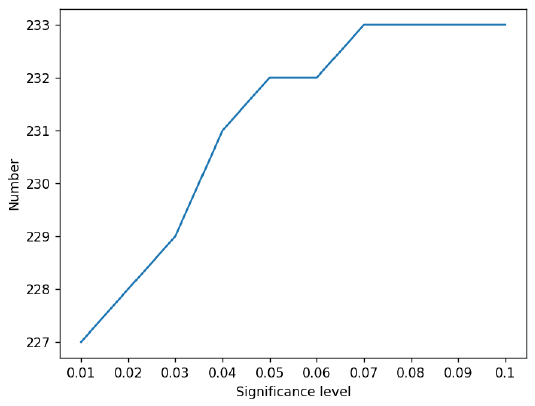
Figure 5. Results of different significance levels.